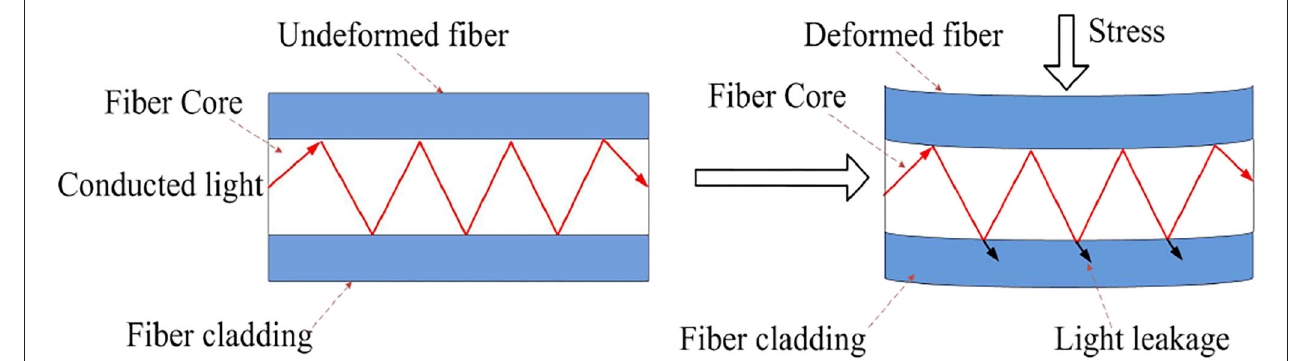
FIGURE 2 | Optical conduction loss caused by mechanical deformation of micro-bending fiber under the action of